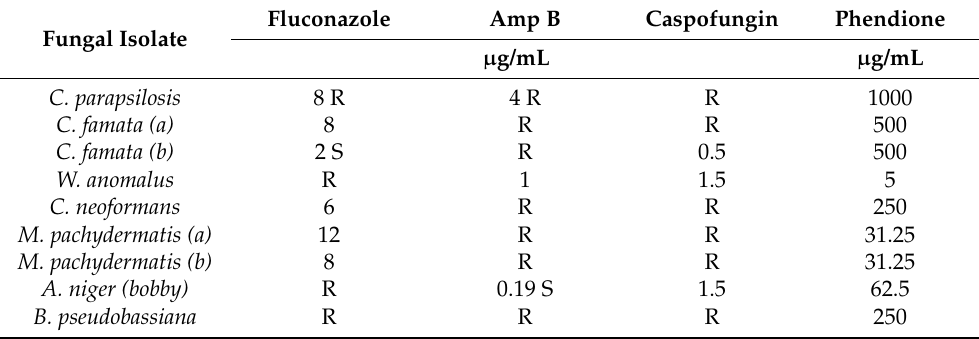
Table 3. MIC results for fungal dermal isolates of companion animal disease for fluconazole, AMP B, caspofungin (based on gradient strip method) and phendione (based on microdilution). Fungal